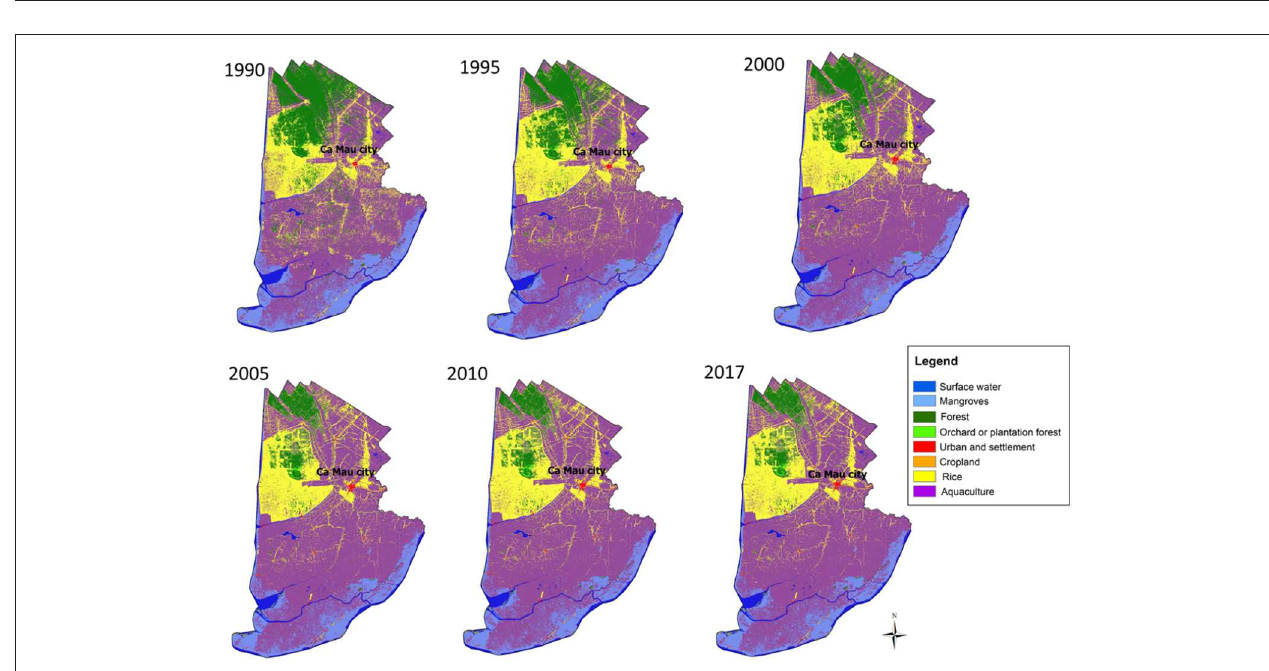
FIGURE 7 | Land cover change in Dak Lak with 5 year intervals from 1990 to 2017. The statistics can be found in Supplementary Table 4 .